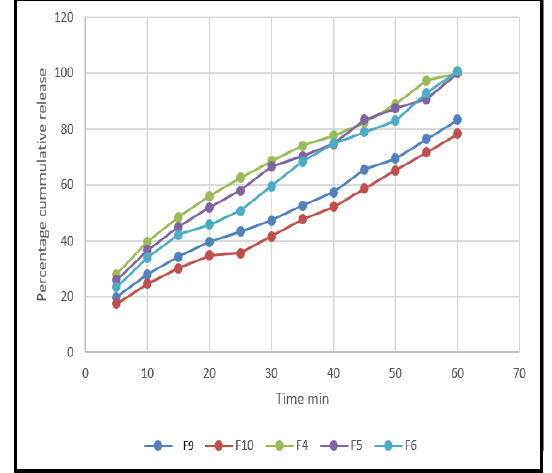
Figure 3. In vitro release studies of LXM MN formulations in phosphate buffer pH 7.4 and at a temperature of 35± 0.50 °C.